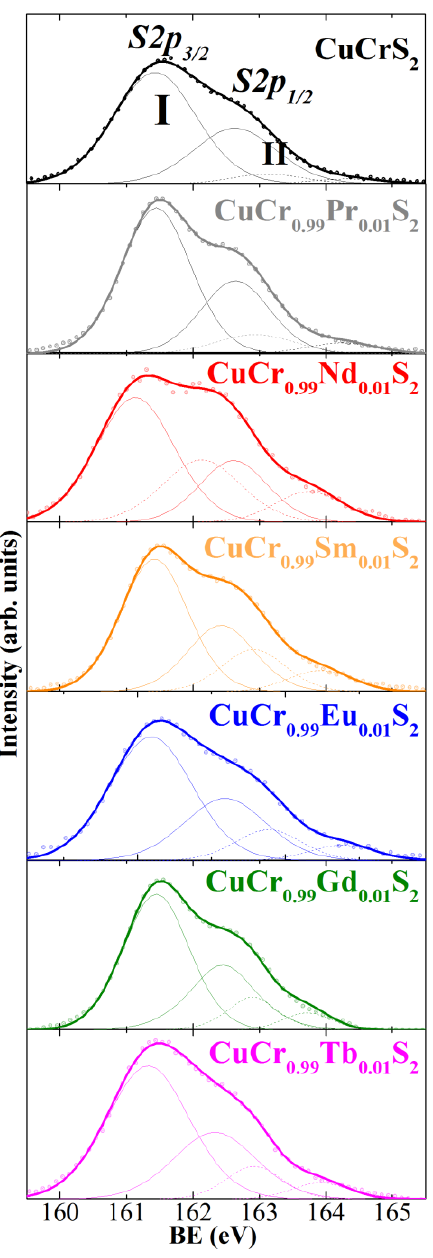
Figure 4. X-ray photoelectron S2p region for CuCrS 2 and CuCr 0.99 Ln 0.01 S 2 (Ln = Pr – Tb). The study of the lanthanide oxidation state in CuCr 0.99 Ln 0.01 S 2 solid solutions is of special interest due to the fact that contribution of the Ln4 f level is assumed to affect the electronic structure and, thereby, the physical properties of the compounds studied [25]. The XPS lines of Pr, Nd, Sm, Eu, Gd and Tb in CuCr 0.99 Ln 0.01 S 2 are shown in Figure 5. As can be seen in Figure 5 the Pr4d line lies in the same energy region as the Cu3s line. How- ever, the deconvolution of the experimental data allowed one to measure the BE value of the Pr4d line as 117.9 eV (Table 2). The measured BE is close to one for Pr 2 O 3 (BE ≈ 117.5 eV) and, thereby, corresponds to Pr 3+ [45]. The Ln3d 5/2 region (Ln = Nd, Sm, Eu, Gd) ex- hibited an intense single peak (Figure 5). The BE values of corresponding lines are listed